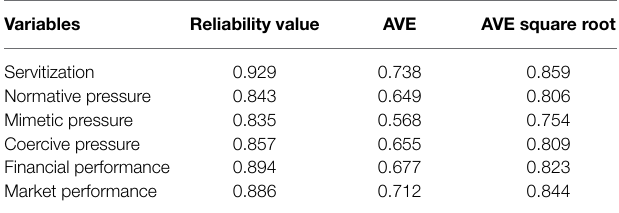
TABLE 4 | Reliability analysis and Validity analysis on all variables used in this study.